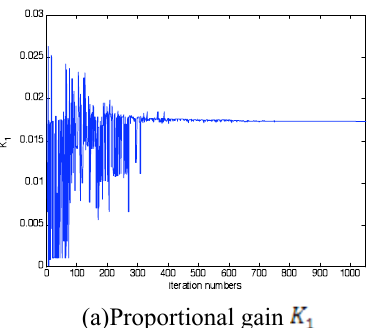
Fig.12. Evolution of the cost